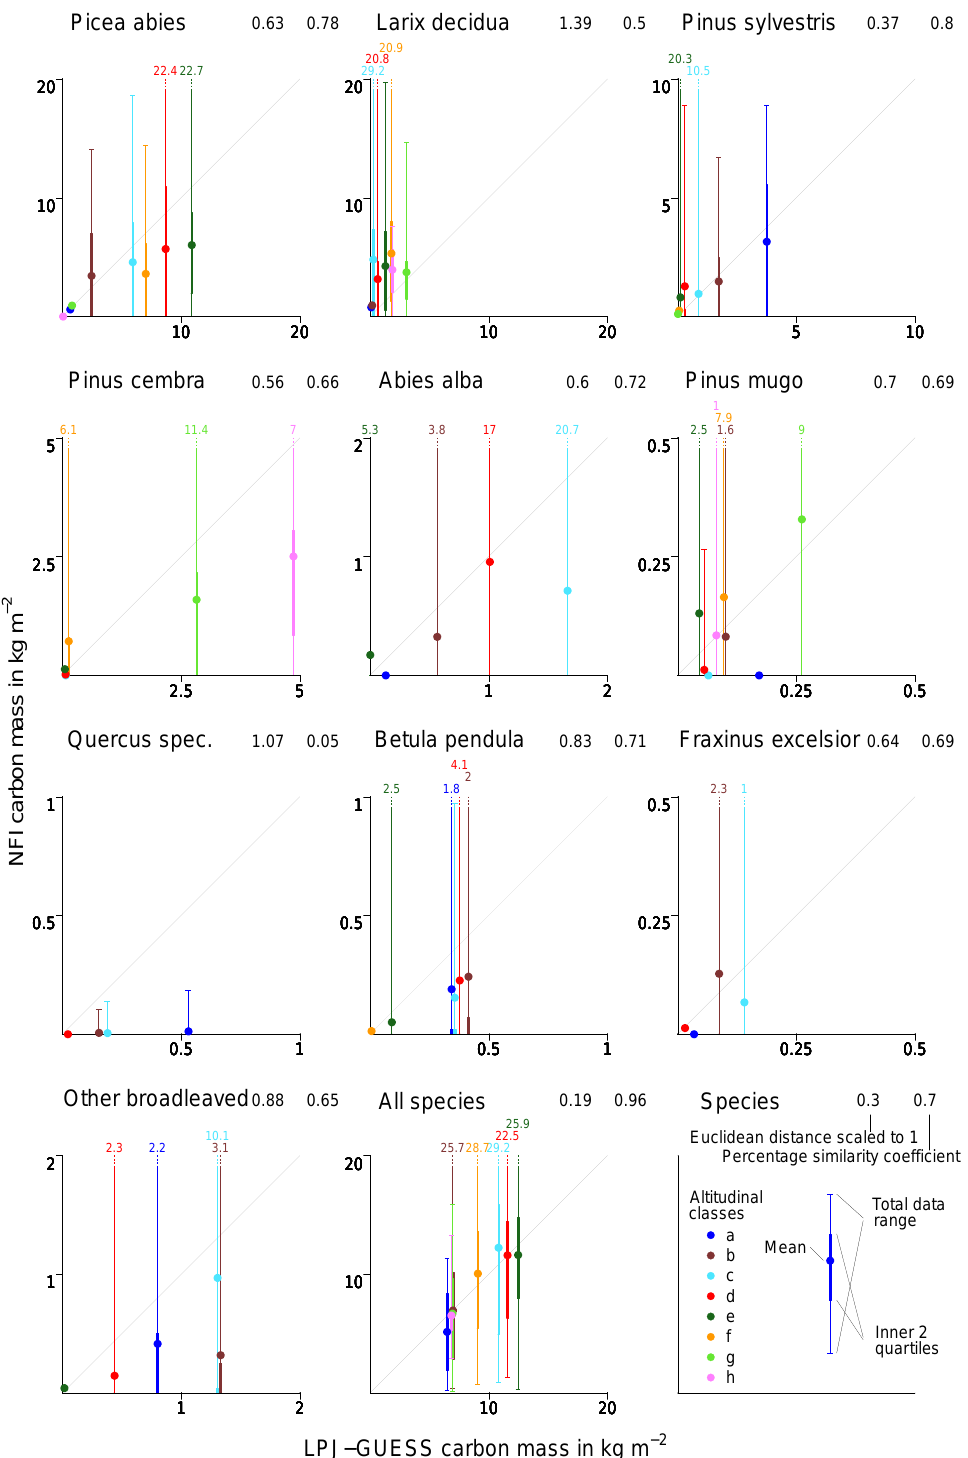
Fig. D1. Comparison of the NFI1 data with LPJ-GUESS runs. LPJ-GUESS results were produced using 400 replicate patches and altitude- specific disturbances (see RID in Table 2). See the lower right chart for descriptions. Note that for some species the two inner quartiles of the NFI data are located at 0 in all plots.